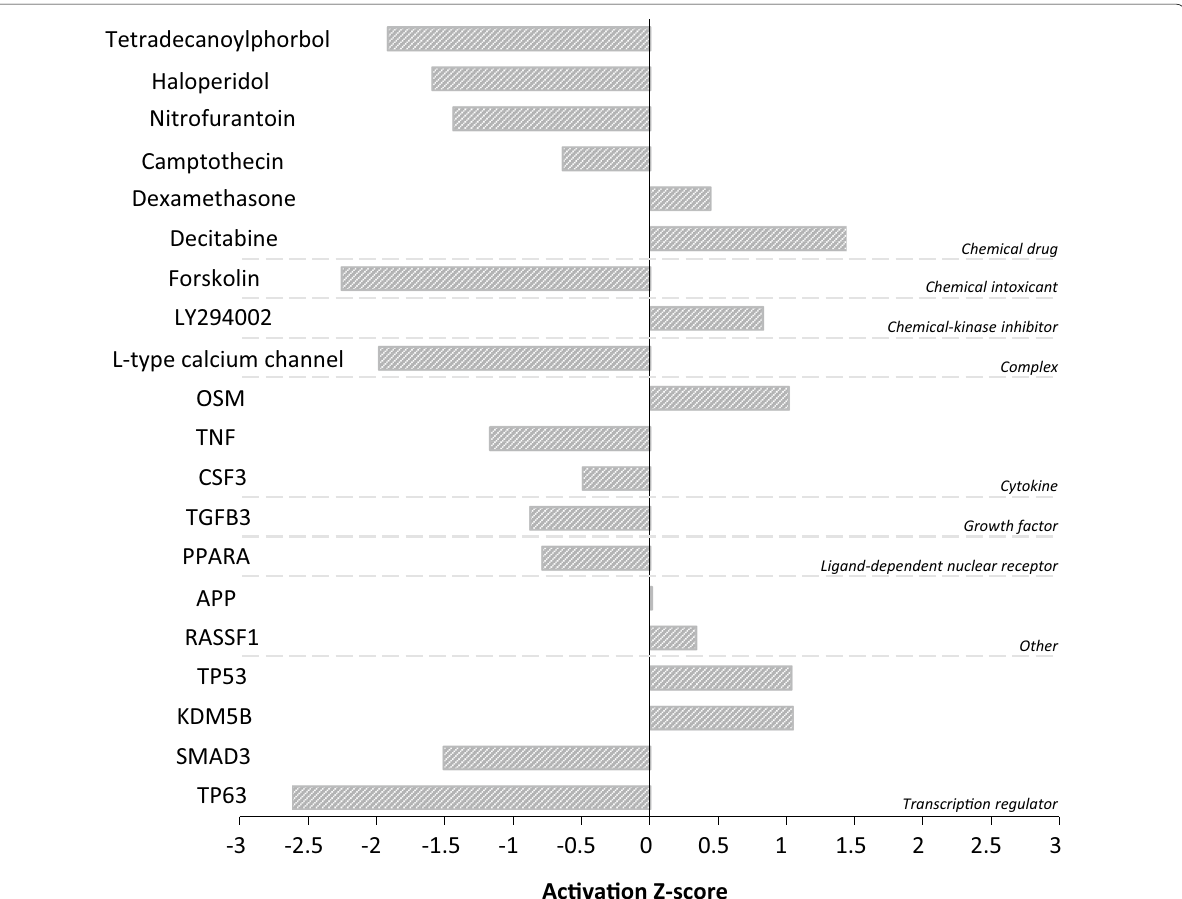
Fig. 4 Top upstream regulators predicted by Ingenuity Pathway Analysis in smoker buccal mucosa. A positive z score indicates activation, while a negative z score indicates